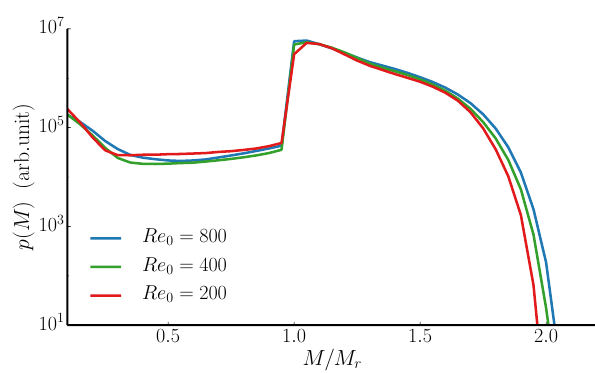
Figure B1. DSD dependence on viscosity (quantified by the refer- ence Reynolds number Re 0 ) in a cloud-top mixing layer. The DSDs were measured 540s after the start of the simulations. The overall convergence is good, pointing to a small role of the viscous effects and of the unresolved small